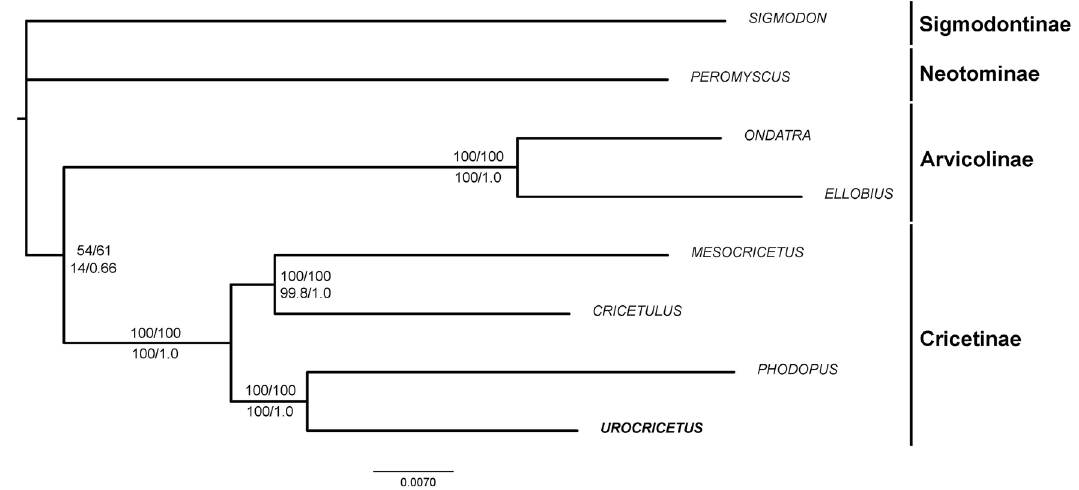
Figure 5. ML phylogeny of Cricetinae as deduced from concatenated alignment of 25 nuclear genes. Clade support is shown at the nodes [top numbers: ML fast bootstrap via edge-linked model (%)/ML fast bootstrap via edge-unlinked model (%); bottom numbers: SH-aLRT support (%)/aBayes support]. Representatives of subfamilies Arvicolinae, Sigmodontinae, and Neotominae serve as